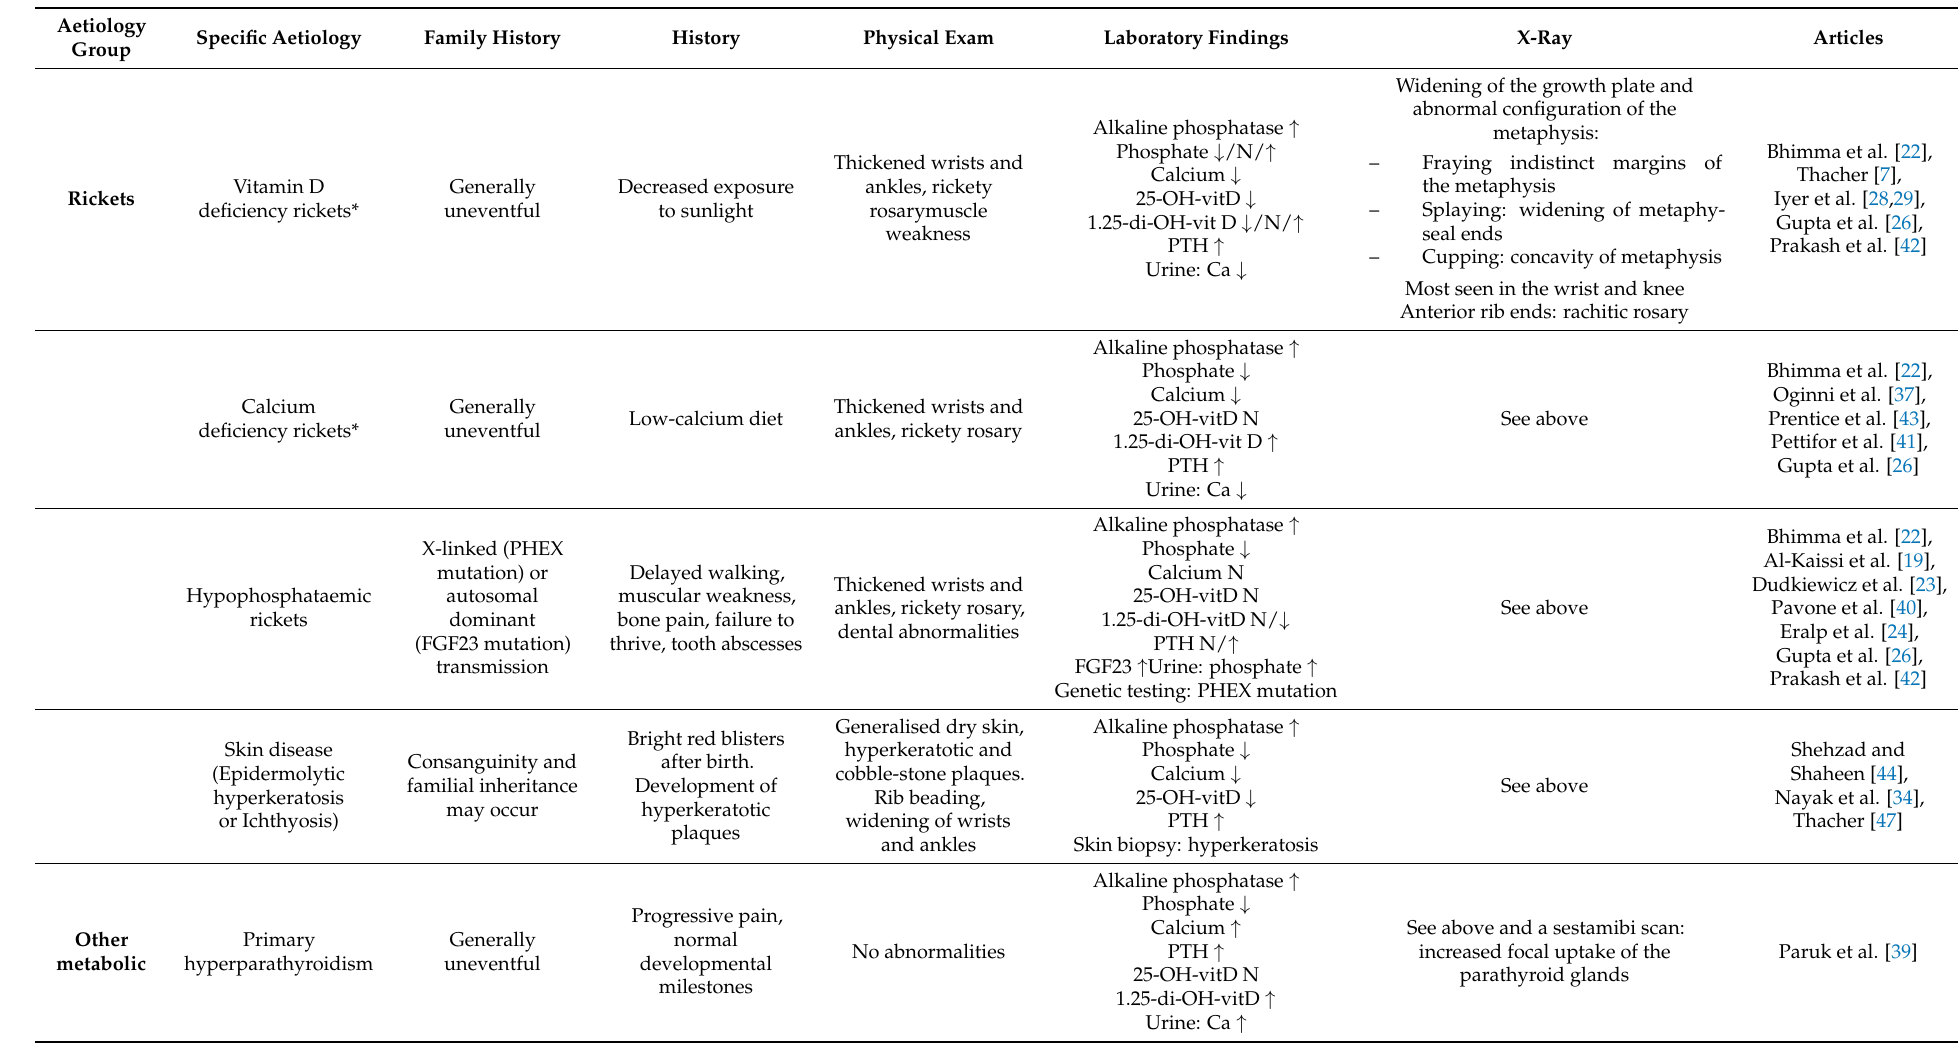
Table 3. An overview of the clinical presentation of each specific aetiology.